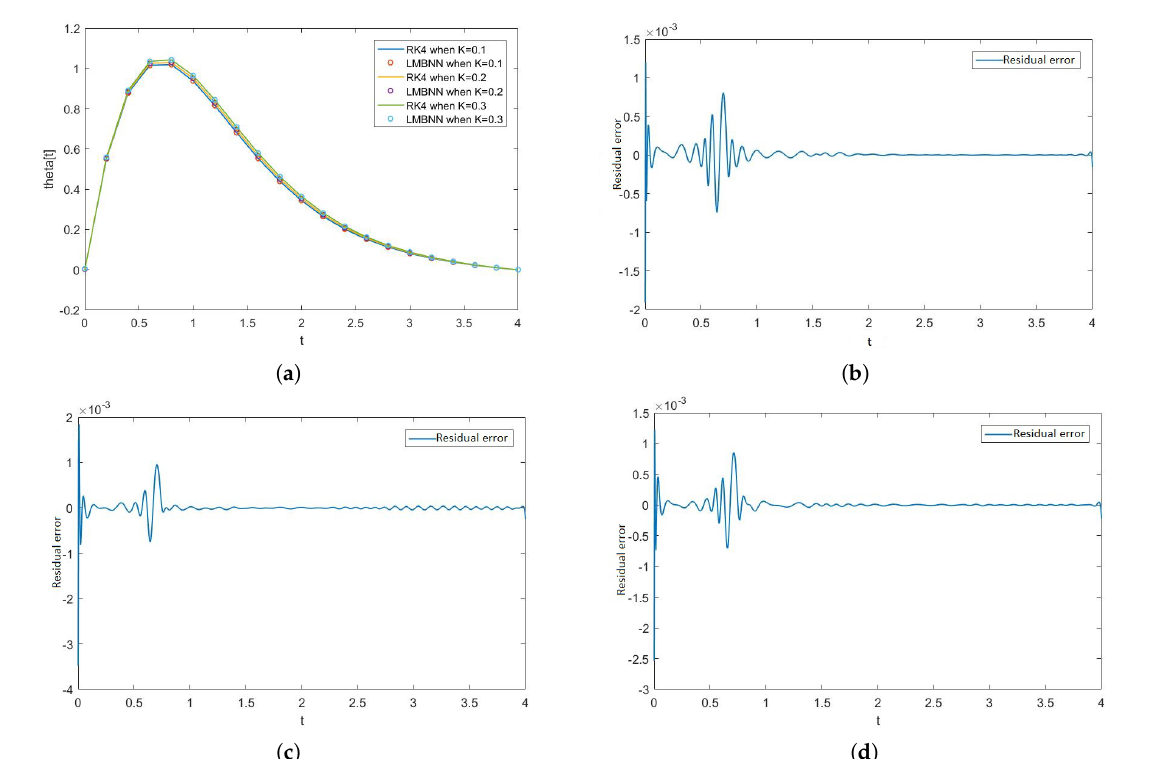
Figure 7. Figures of Θ and error graphs in the solution obtained from RK4 and LMBNN when K varies. ( a ) Graph of Θ when K varies. ( b ) Error in Θ K = 0.1. ( c ) Error in Θ K = 0.2. ( d ) Error in Θ K =